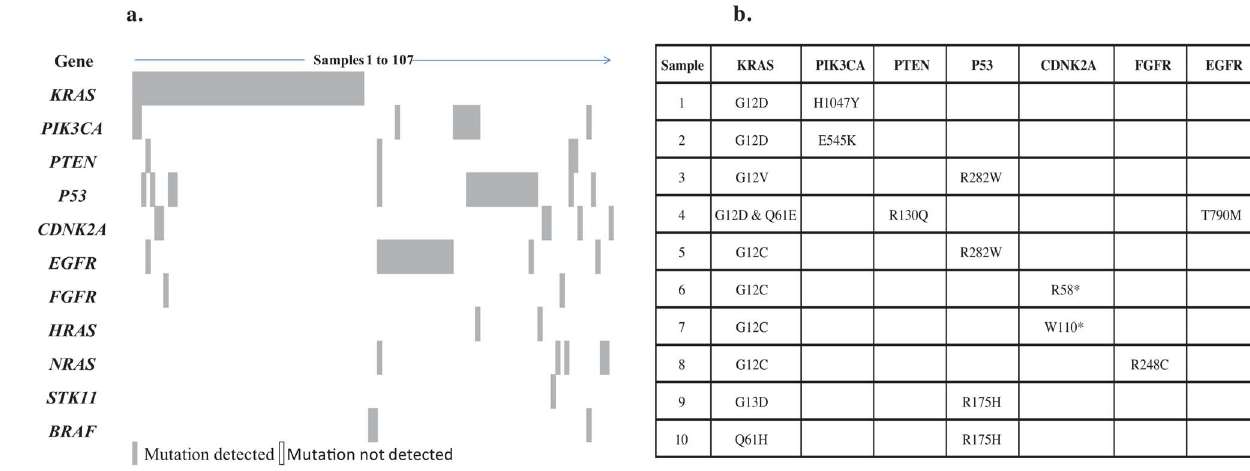
Figure 1. NSCLC samples 1-107 with mutations detected in each gene. B). KRAS mutated samples in NCT00890825 with concomitant